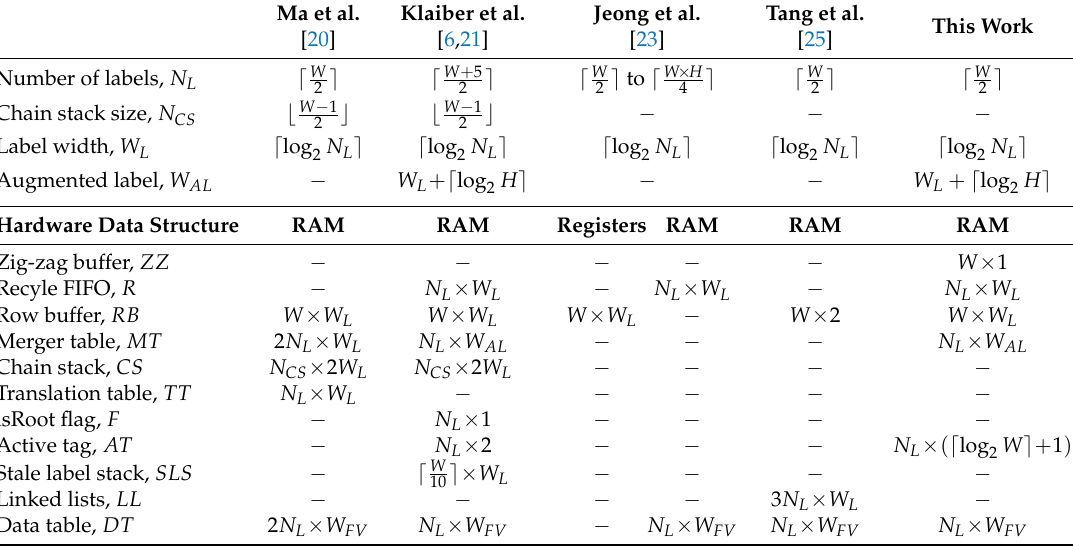
W (cid:101) + 2 (cid:100) log H (cid:101) + (cid:100) log WH (cid:101) . 2 2 2 This Work